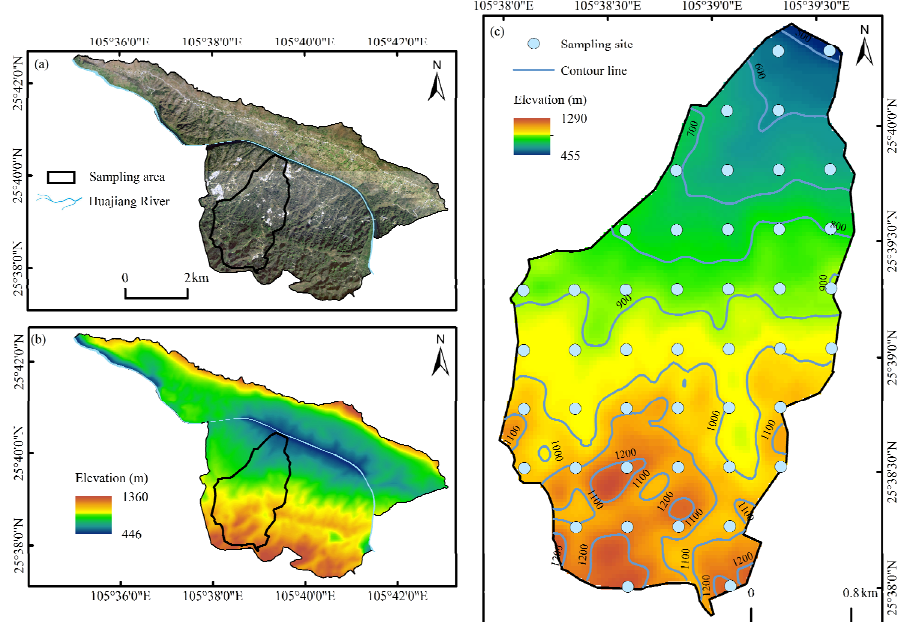
Figure 1. The location of sampling area ( a ); Elevation in the study area ( b ); Distribution of sampling sites ( c ).